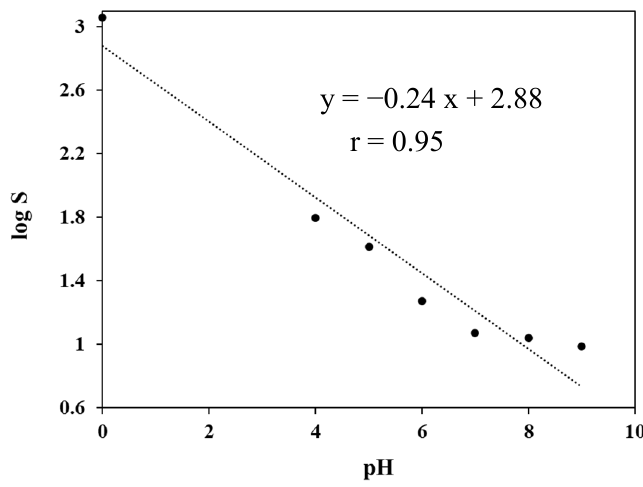
Figure 2. Surface active sites (S) relative to solution pH.